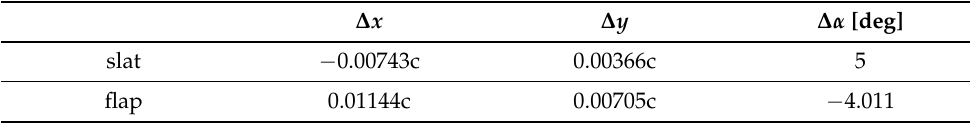
Table 3. Optimised values of the design